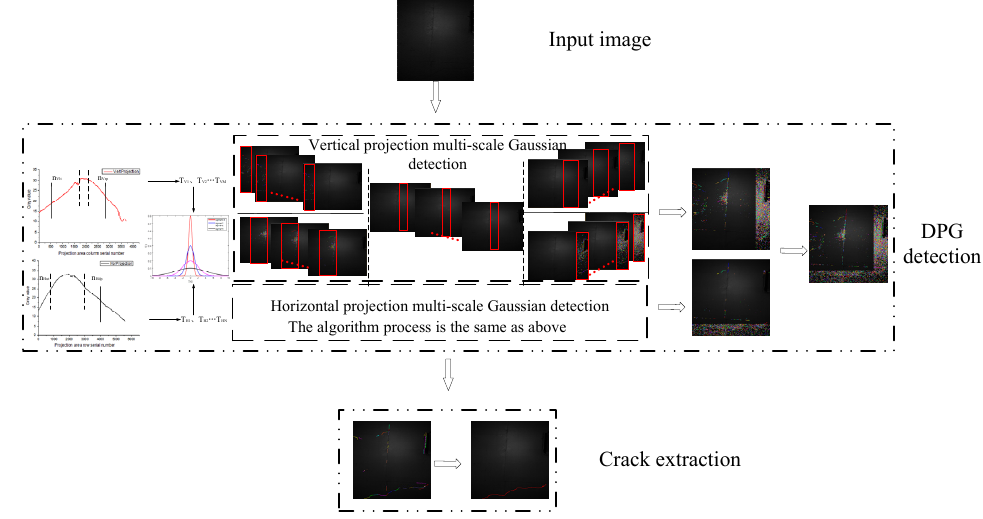
Figure 2. The framework of the algorithm in this paper: input image, dynamic partition Gaussian (DPG) detection, crack extraction.